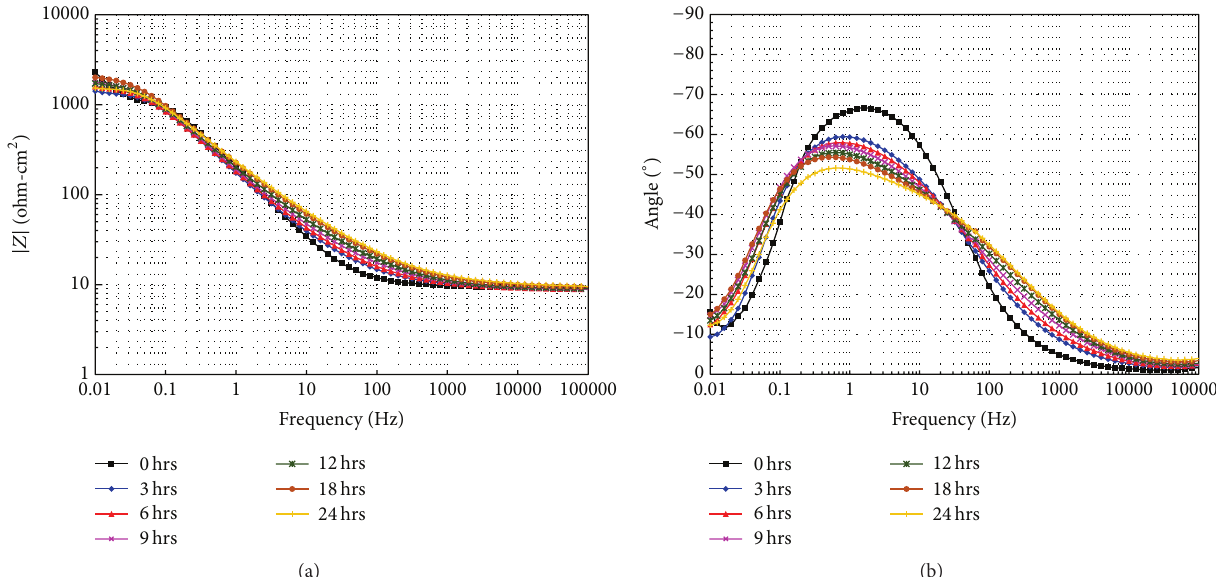
Figure 7: Bode plots for 35Nd magnet tested in 3.5% NaCl solution at 25 ∘ C for 24 hours.